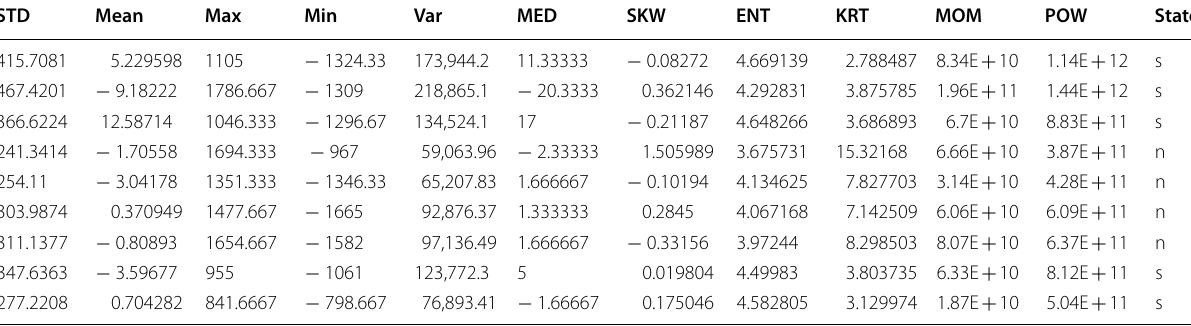
Table 4 Some of the training samples after averaging step STD